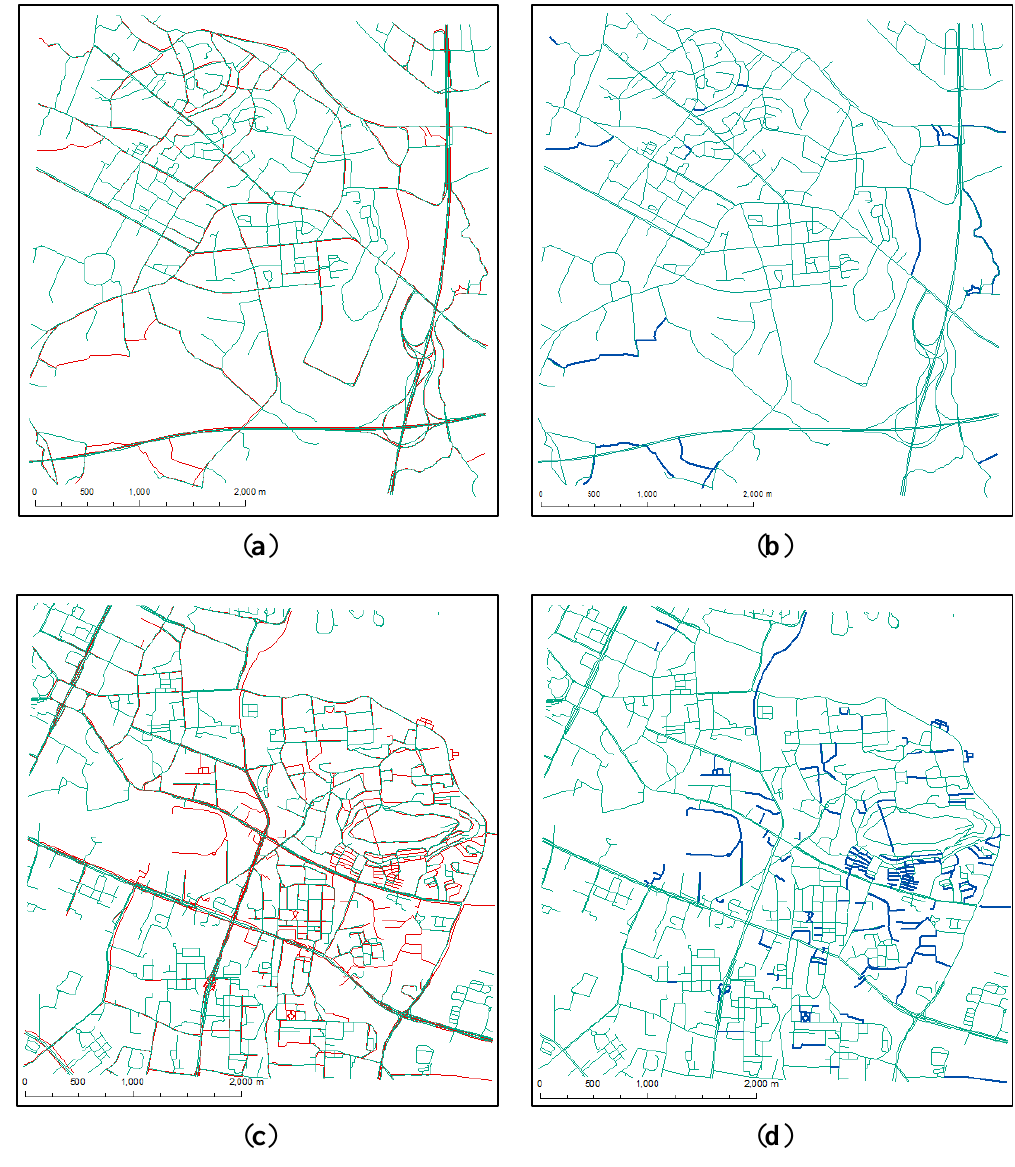
Figure 9. Reference roads (green), OSM roads (red), and detected new roads (blue) for subsets 1 and 3 in Wuhan. ( a ) Reference atop OSM roads for subset 1; ( b ) Detected new roads for subset 1; ( c ) Reference atop OSM roads for subset 3; ( d ) Detected new roads for subset